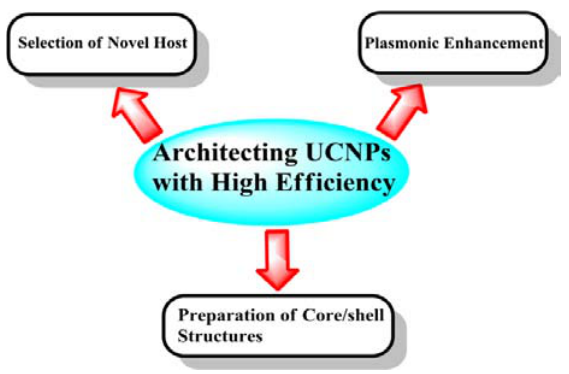
Fig. 2. General strategies to achieve the high e±ciency of